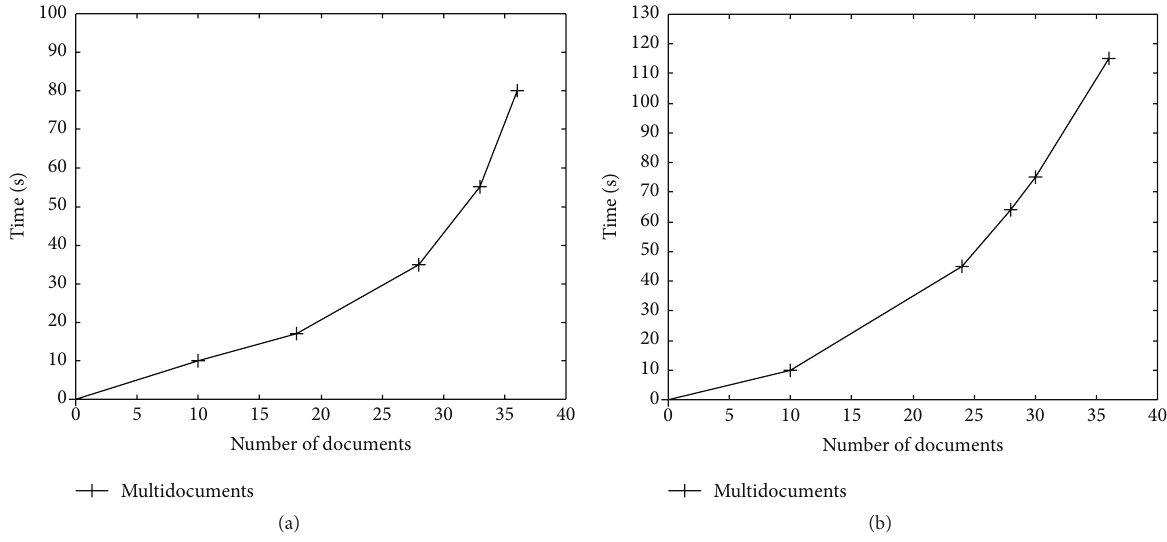
Figure 2: Multidocument summarization: (a) Na¨ıve Bayesian classifier (proposed) and (b) MEAD (existing).